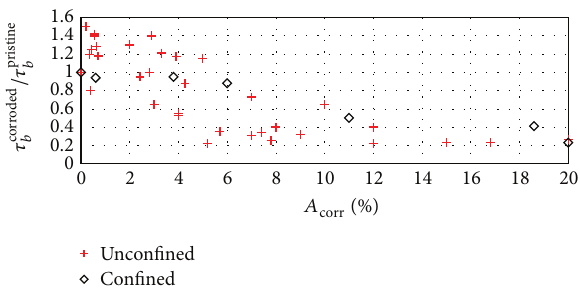
Figure 7: The relationship between bond strength of corroded to noncorroded reinforcing steels and corrosion for confined and unconfined RC samples based on collected experimental